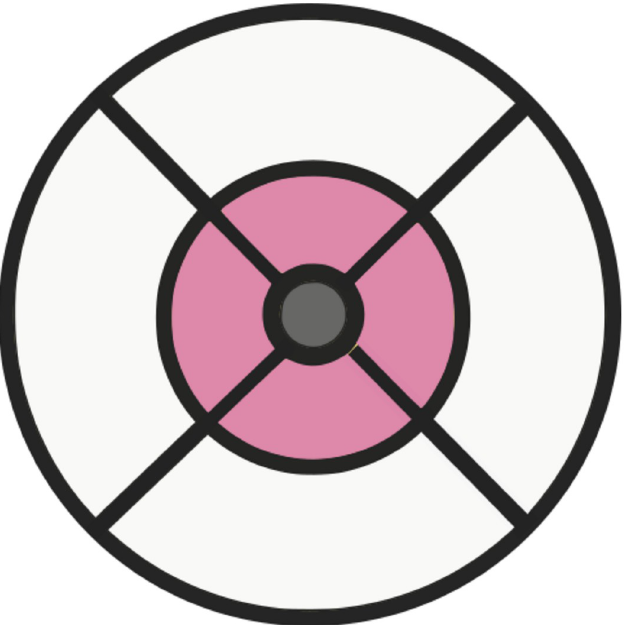
Fig 3. Comparison of concentric rings defined by the ETDRS grid. The macula divided into three concentric fields for comparison utilising the ETDRS grid. The peripheral field is shaded white, the intermediate field is shaded pink and the foveal field is shaded